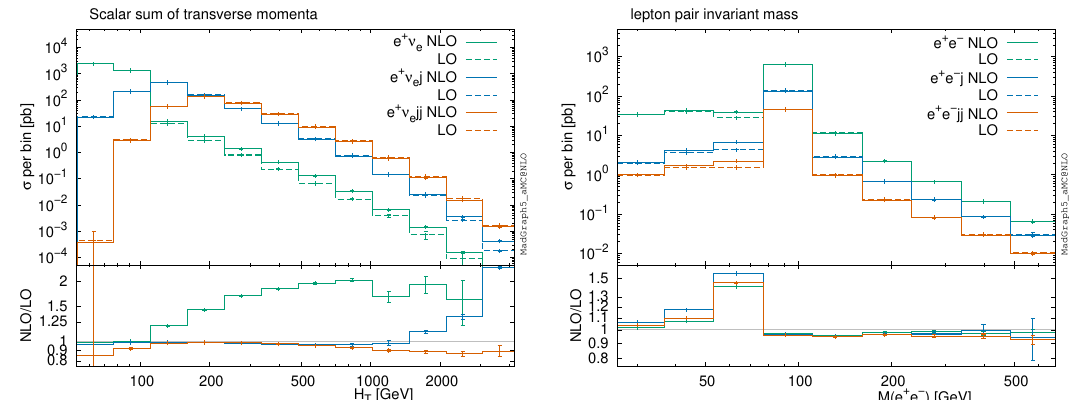
Figure 6. H in W + (cid:3) + jets production (left panel), and dressed-lepton pair invariant mass in T Z (cid:3) + jets production (right